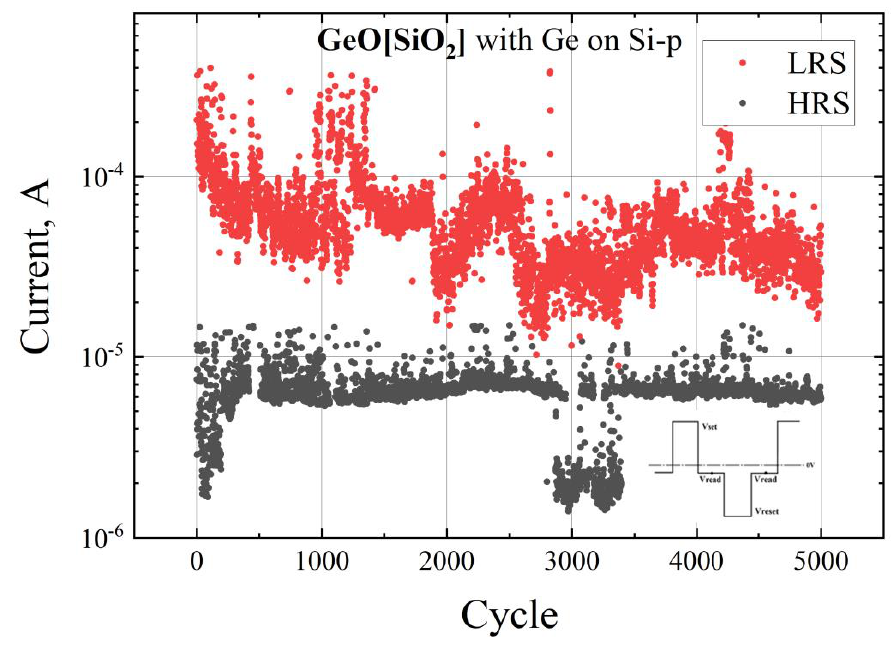
Figure 12. Current during multiple overwrites of sample D.